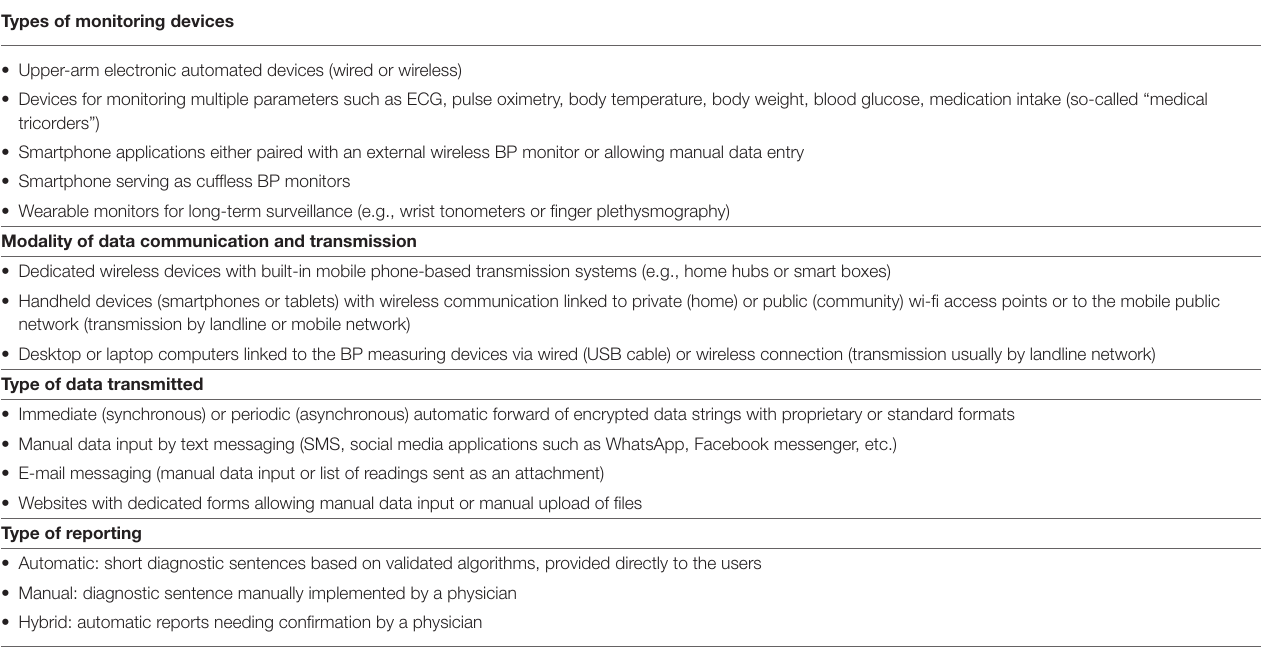
TABLE 2 | Technologies for blood pressure